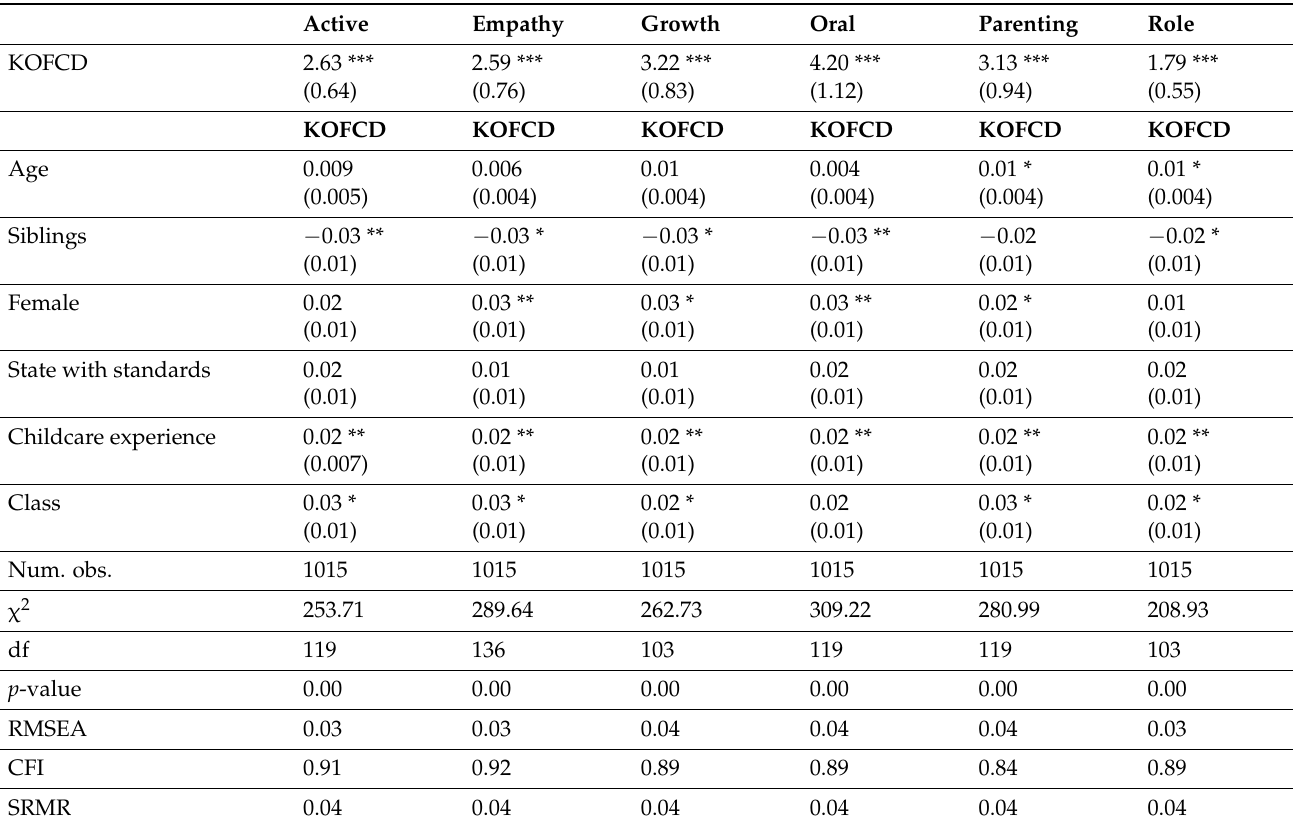
Table 10. Structural equation model of beliefs, demographic characteristics, and previous experience and knowledge. Active Empathy Growth Oral Parenting